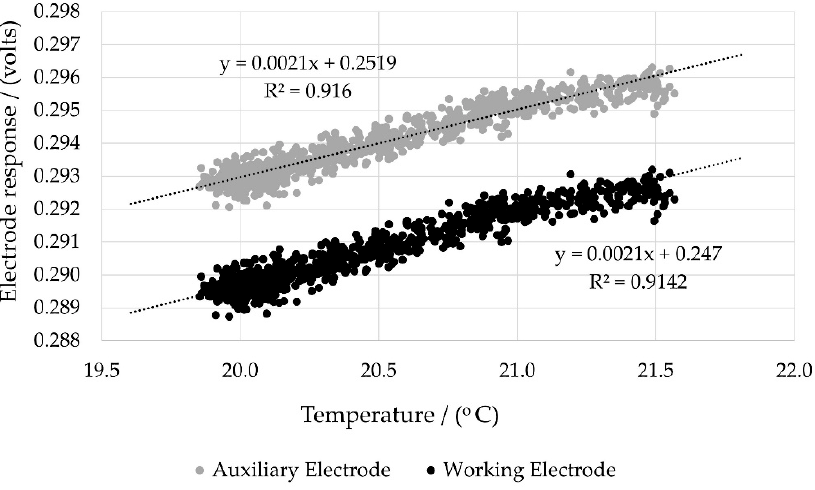
Figure 5. Temperature-dependence of NO electrochemical electrode responses (dT = ± 1.2 ◦ C).